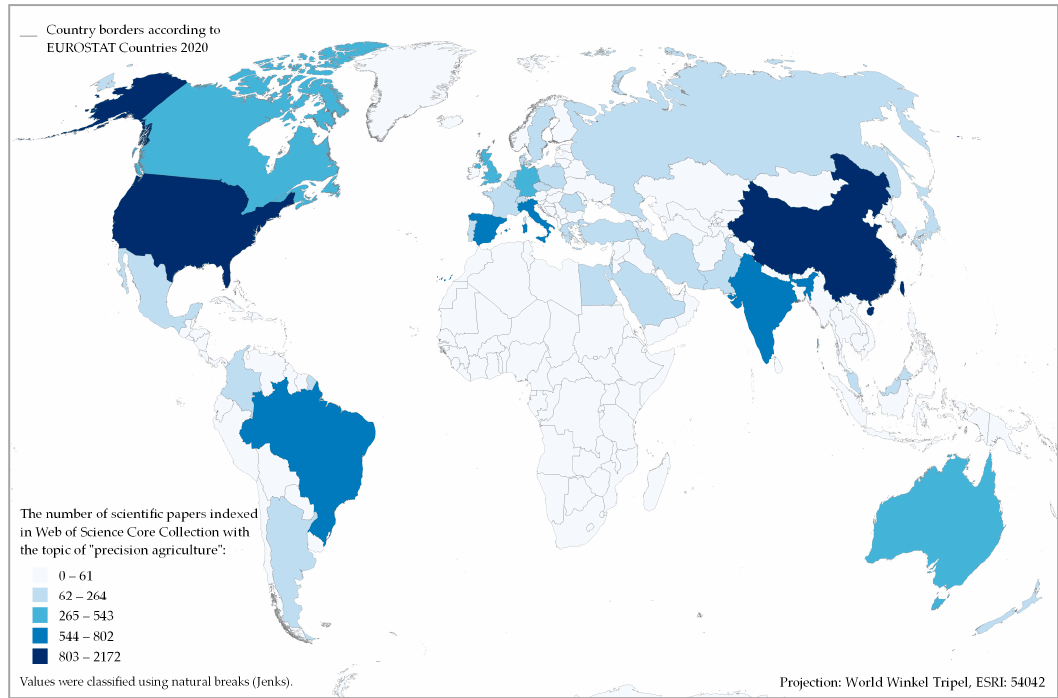
Figure 1. Global map of the number of scientific papers indexed in WoSCC since 2010 with the topic of “precision agriculture”.